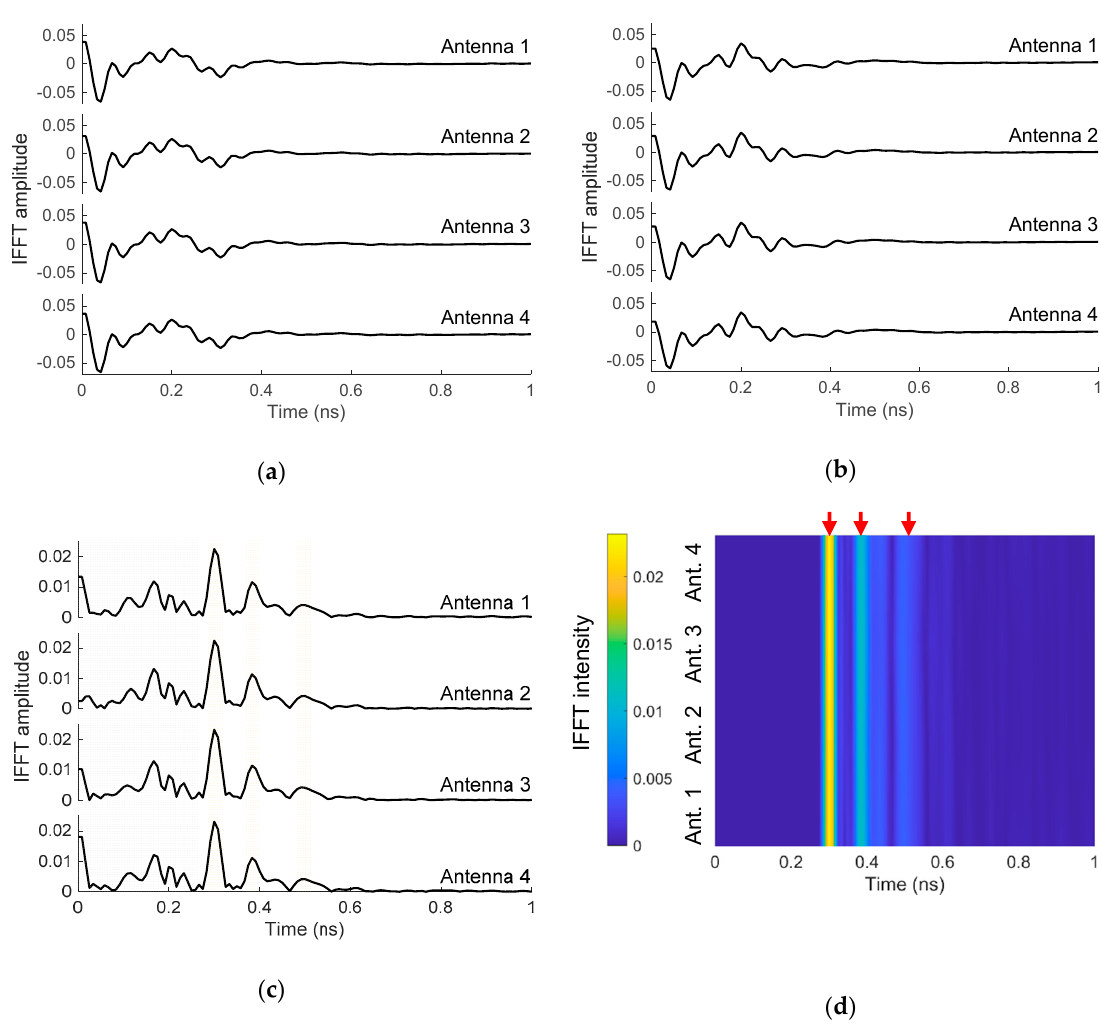
Figure 22. Time domain signals for the antenna response: ( a ) Reference signal without the breast model; ( b ) Antenna response with the breast model; ( c ) Difference signal; ( d ) Intensity of the reflections of the difference signals.